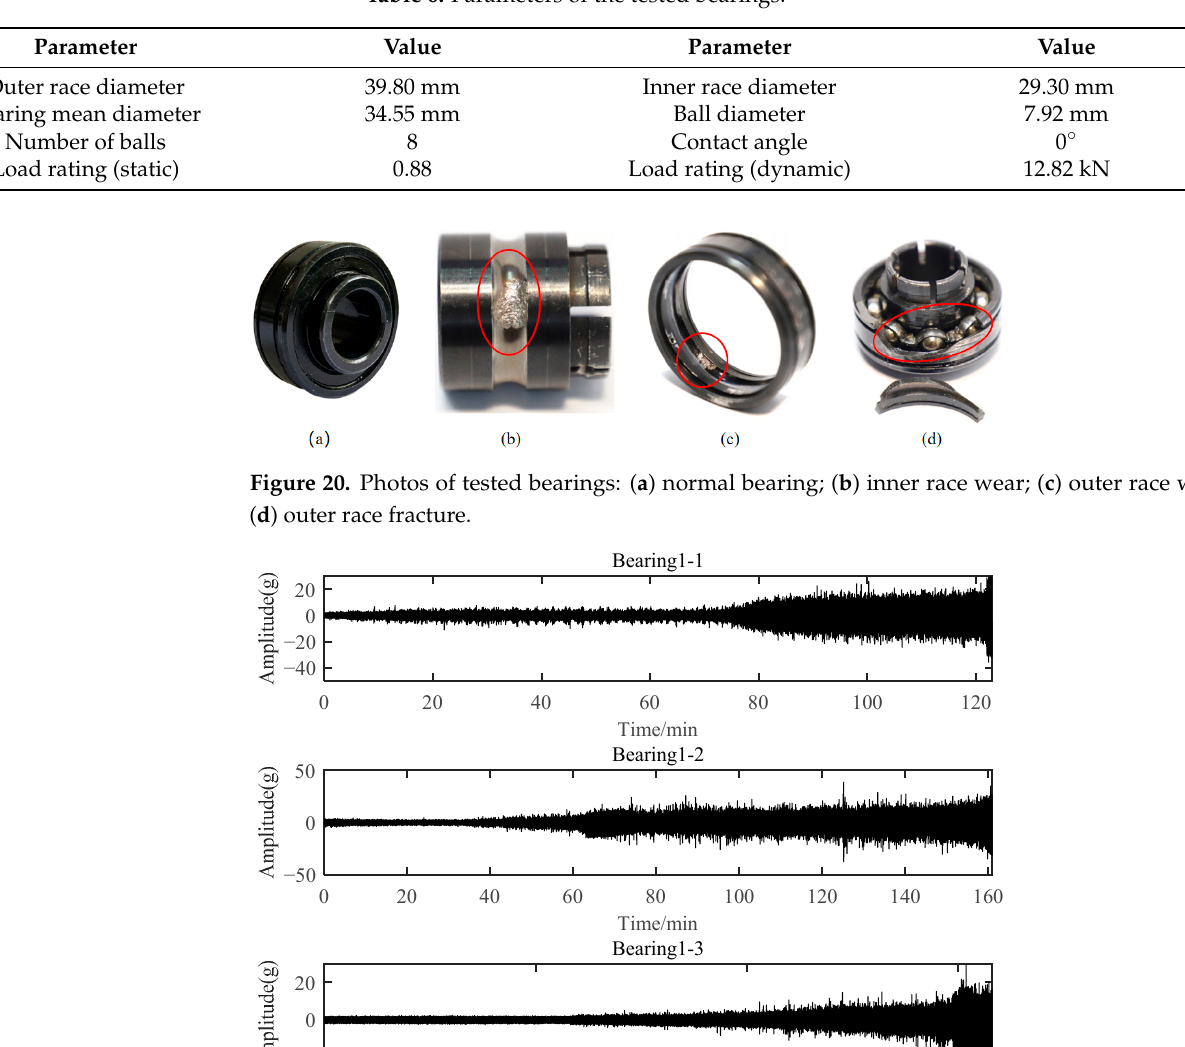
Table 6. Parameters of the tested bearings.